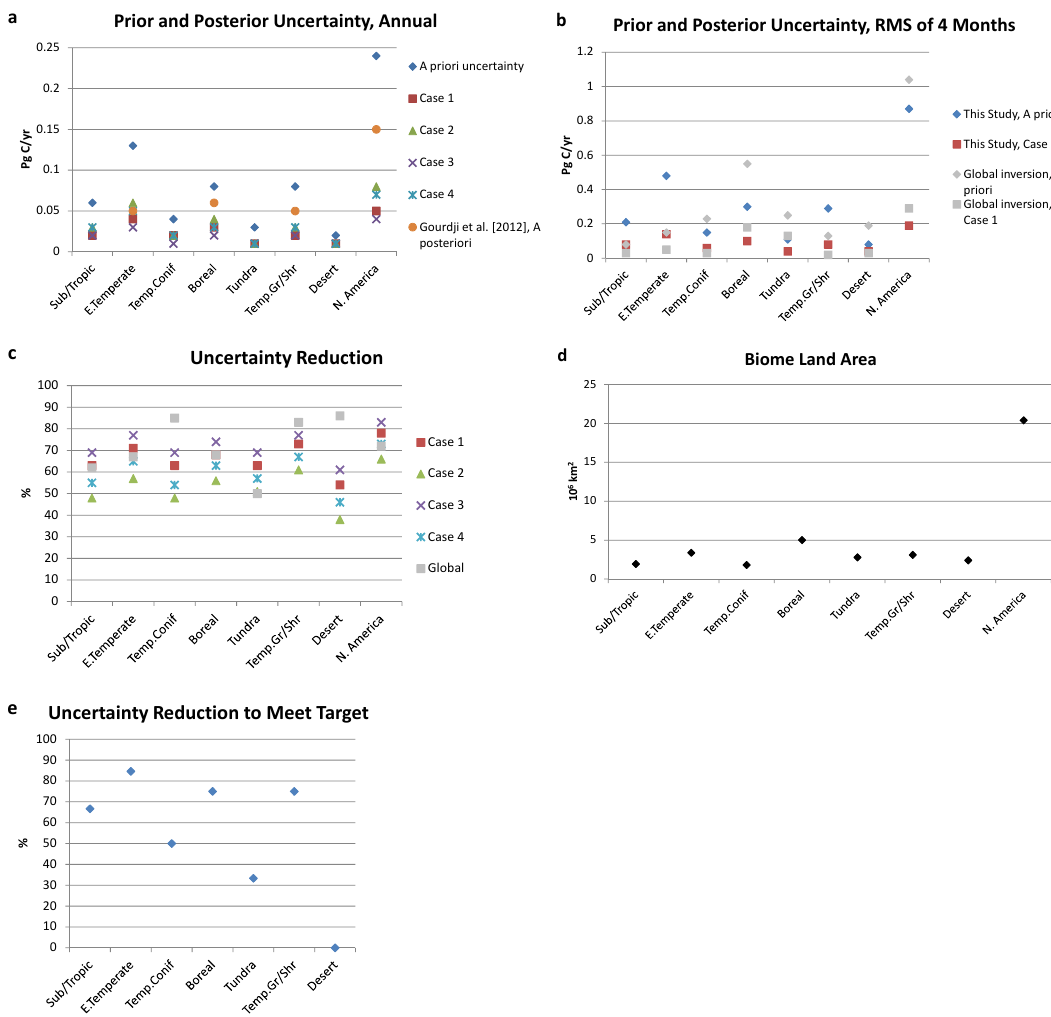
Figure 10. Results aggregated to biomes and continent and compared with other studies. (a) A priori and a posteriori uncertainties for the year, including results from Gourdji et al. (2012). (b) RMS of the four monthly uncertainties, including results from the global inversion. (c) Fractional uncertainty reductions. (d) Land area of the biomes. (e) Fractional uncertainty reduction necessary to meet the target requirement. Gourdji et al. (2012) reported results for only the three biomes that were well constrained by their in situ observation network, along with results aggregated over the full continent; we show the approximate average of their “Simple” and “NARR” inversions. The figure does not include a priori uncertainties for Gourdji et al. (2012) since their method does not rely on a priori